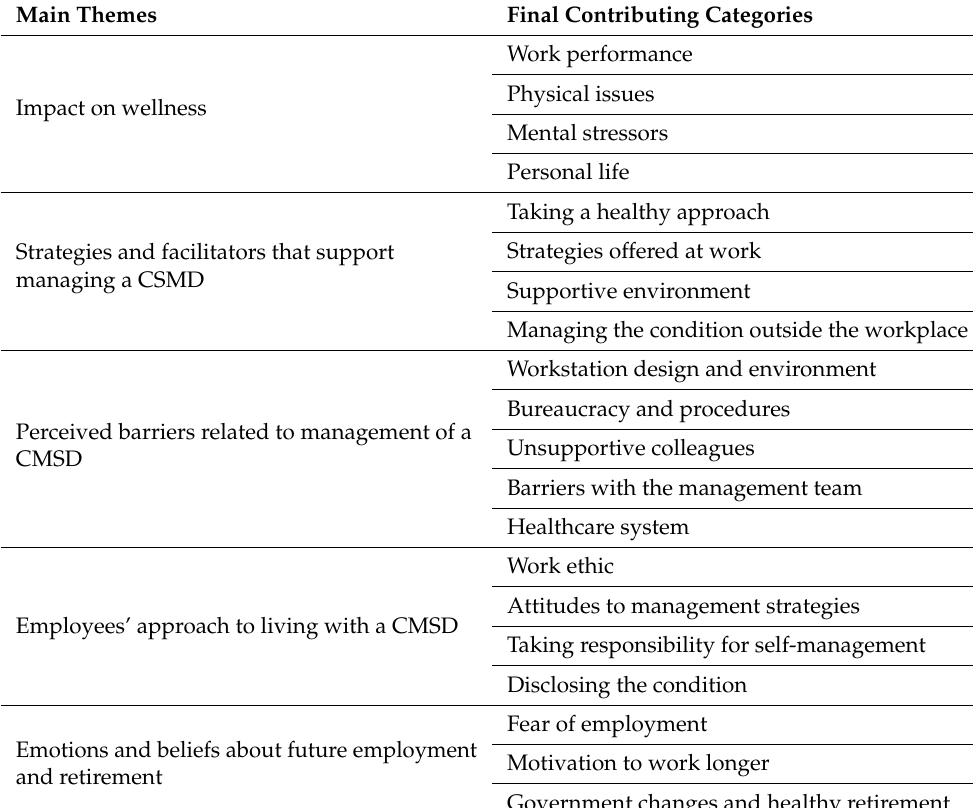
Table 6. Final categories that contributed to each qualitative